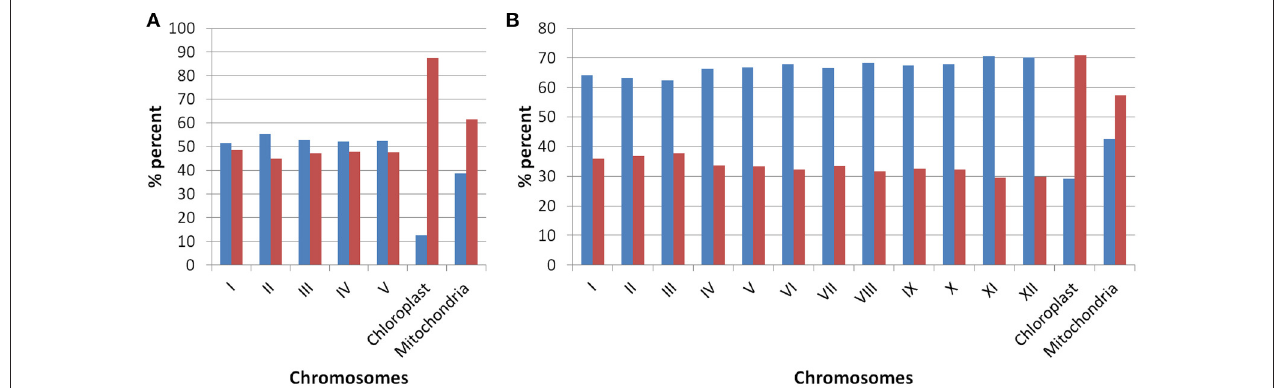
FIGURE 1 | The plot shows the occurrences of old “prokaryotic” genes on various chromosomes in Arabidopsis (A) and Oryza sativa (B). The bar in the graph depicts the number of genes present on the respective chromosome. The “blue” color shows the total number of new genes while “red” color shows the number of old “prokaryotic” genes present on respective chromosomes.